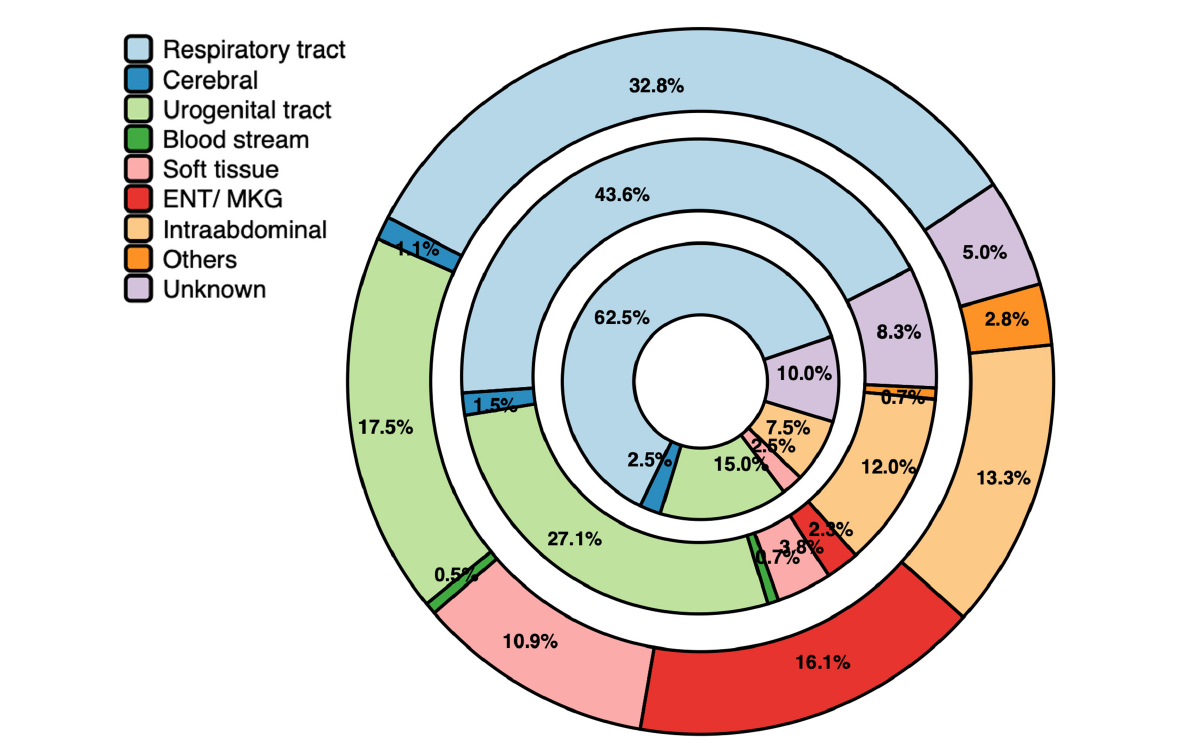
FIGURE3 Sources of infection. Results were illustrated as circles represented the distribution in percentage (%) of the infection sites in the three subgroups (I: infection n = 1,103, outer circle; II: sepsis n = 133, middle circle; III: septic shock n = 42, inner